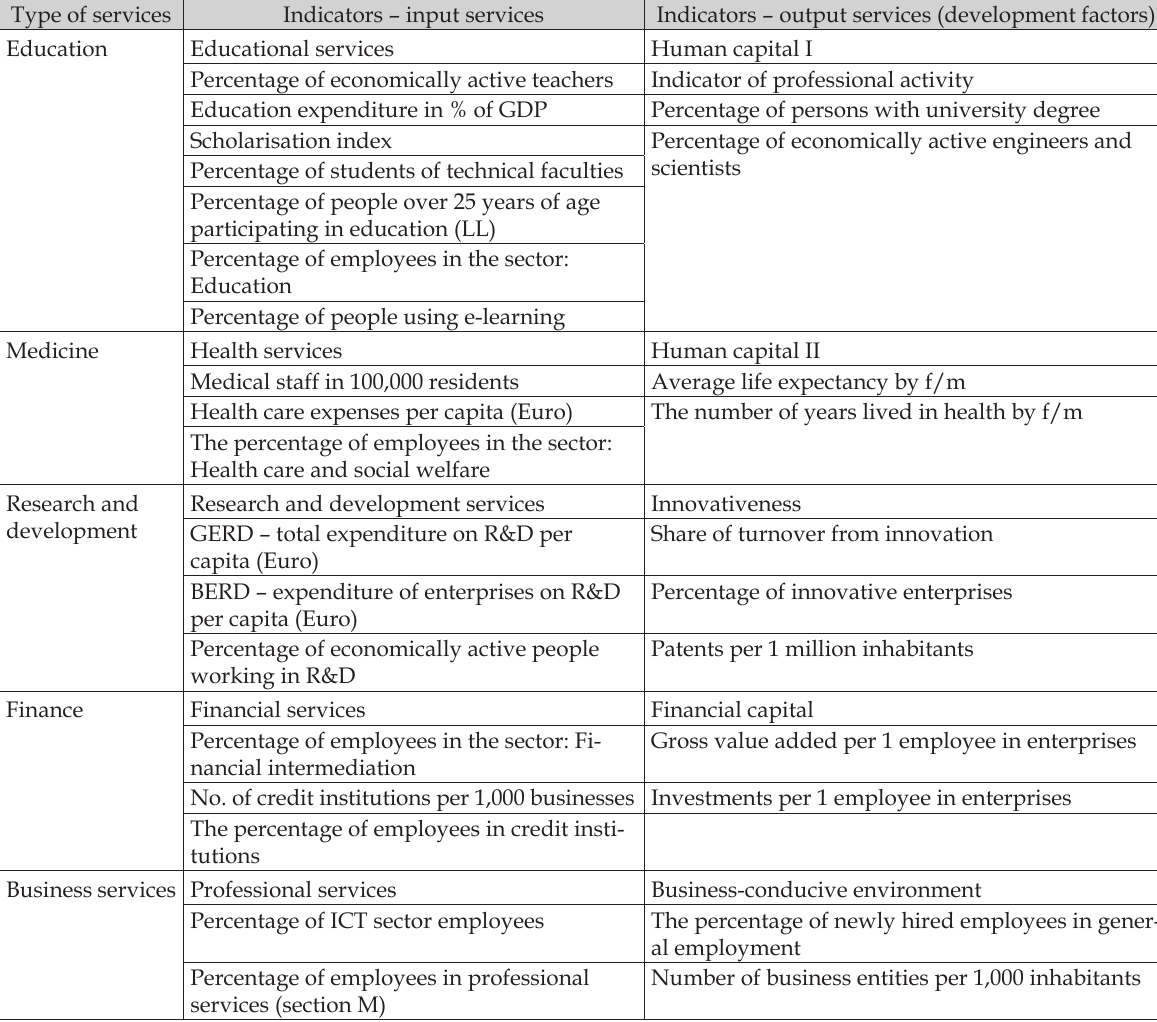
Table 1. Indicators of the level of development of modern